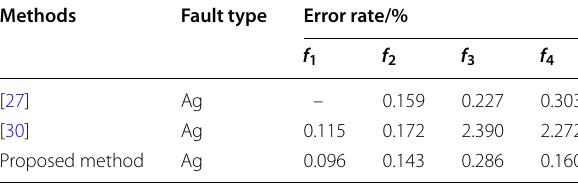
Table 5 Comparison results of fault location Methods